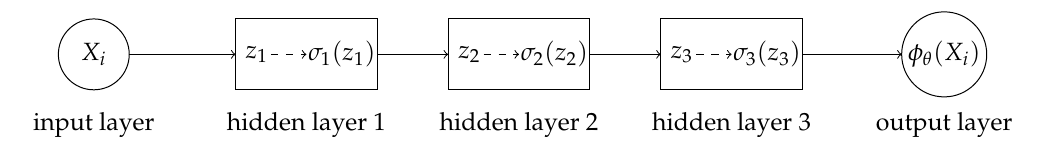
Figure 2. The data transmission process of a neural network that contains three hidden layers. Algorithm 1 Framework of DNNs for solving finite-time survival